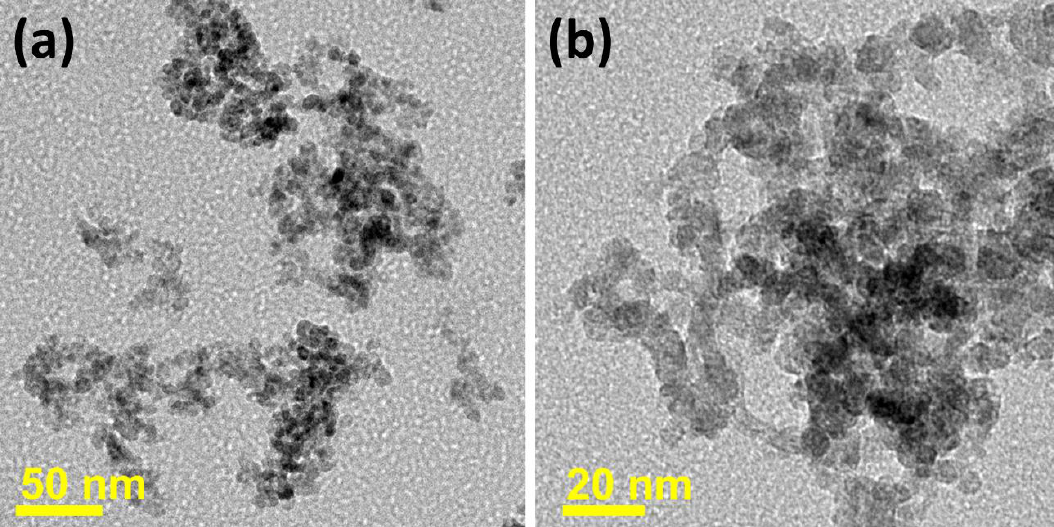
Figure 2. Transmission electron microscopy images of ZnS QDs at different magnifications. ( a ) Agglomerated and overlapped QDs, and ( b ) high magnification image illustrating the different sizes QDs.